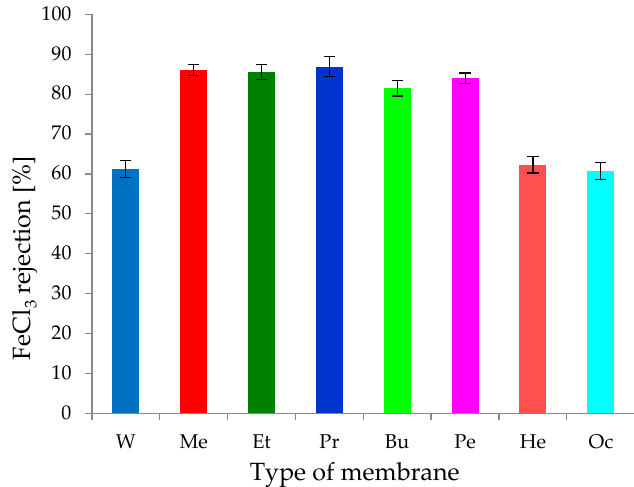
Figure 13. Rejection coefficient (R) for FeCl 3 solution.